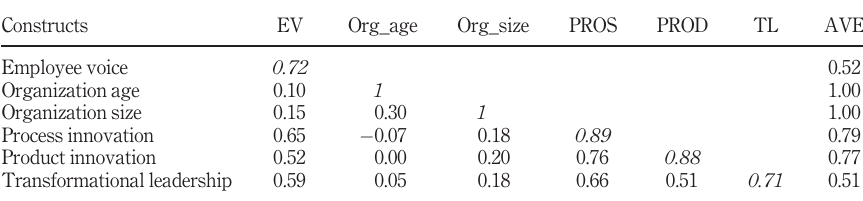
discriminant validity (Fornell and Lacker